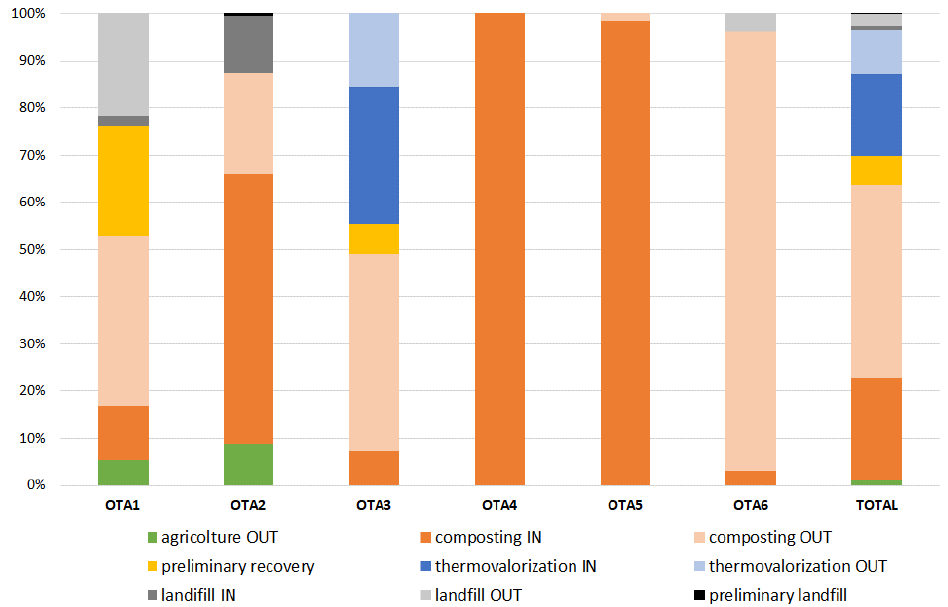
Figure 2. Destinations of the sewage sludge produced in the WWTPs located in the Piemonte region .